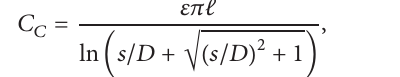
Figure 1: Equivalent distributed circuit model of an individual CNT (shell in a MWCNT) [13].